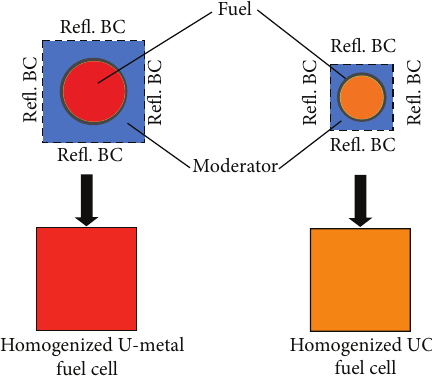
Figure 3: Fuel cross-sections generation.